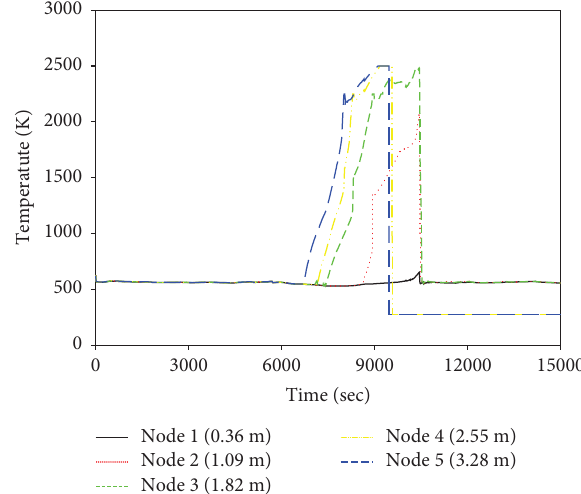
Figure 8: CINEMA results on fuel cladding surface temperature in TMI-2 severe accident.